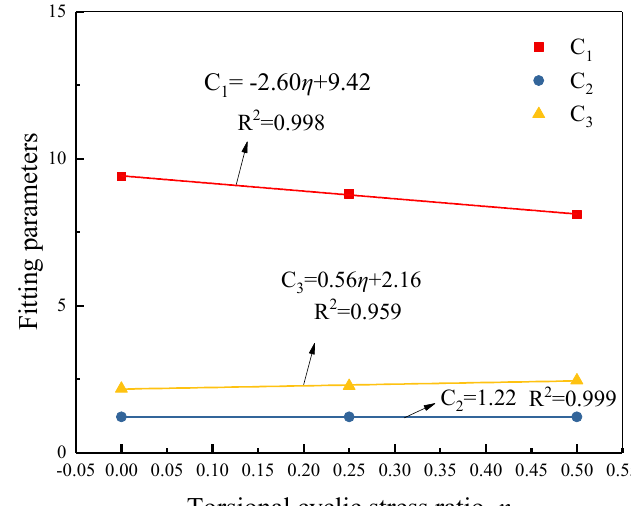
Figure 8. Relationship between parameters C 1 , C 2 , C 3 , and η .